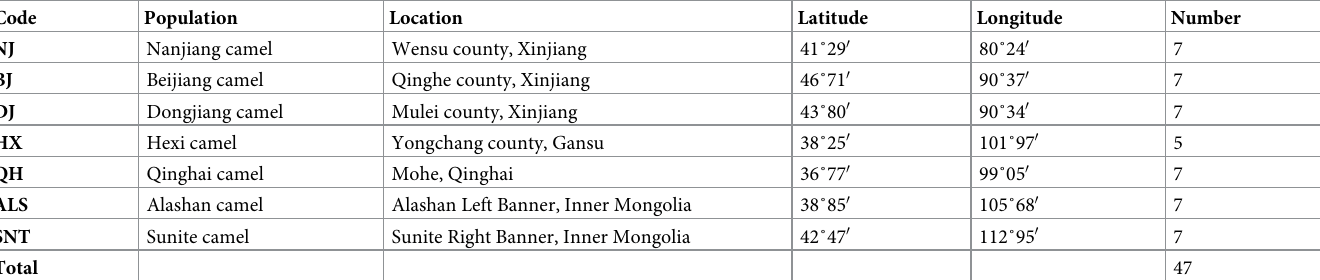
Table 1. Information for domestic Bactrian camels in the seven sampled sites of China.